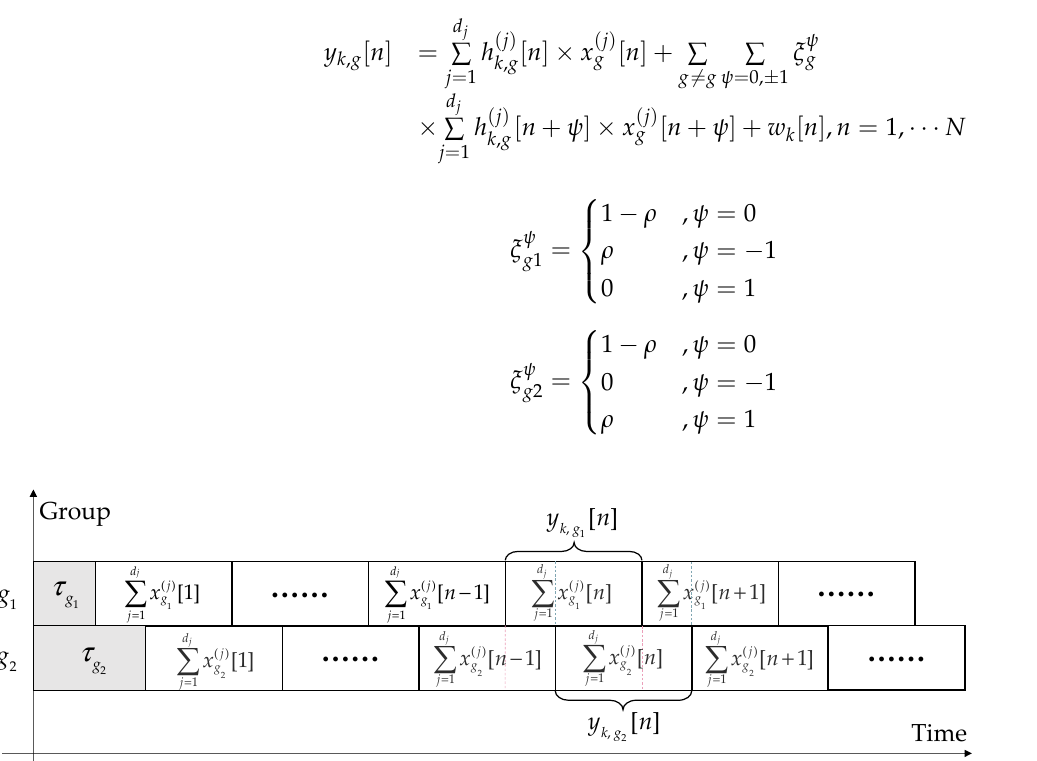
Figure 7. Receiving signal structure.